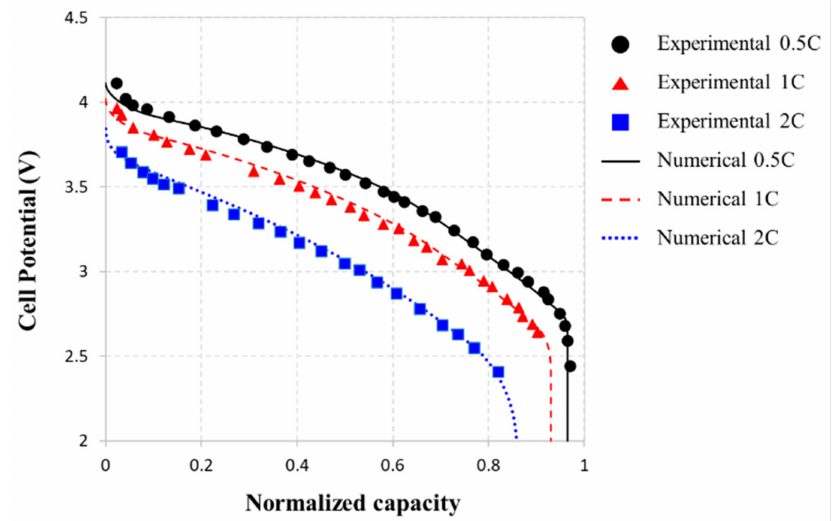
Figure 2. Comparison of discharge curves of the LIB cell between the experiment [26] and numeri- cal analysis.